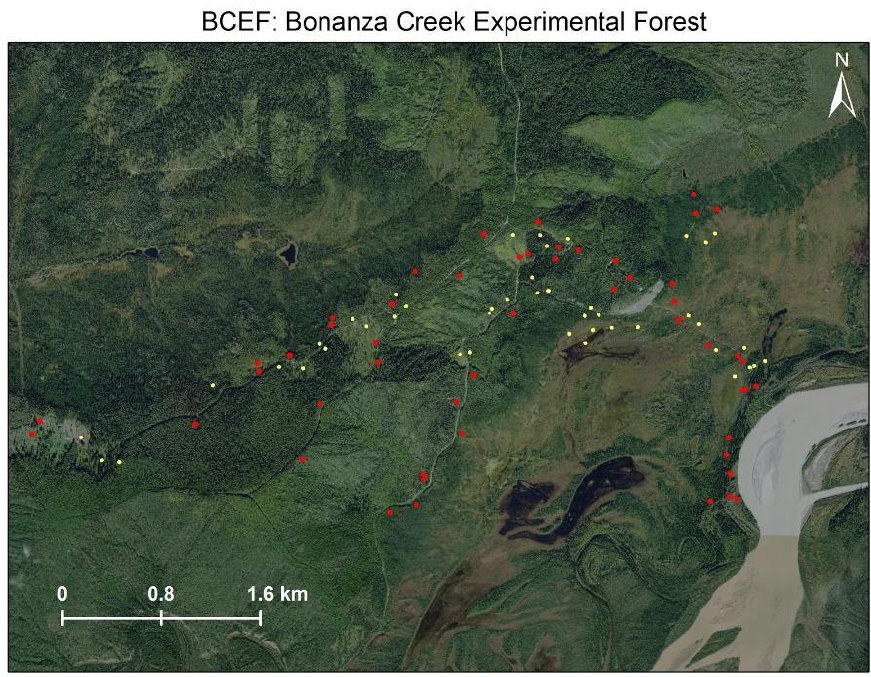
Figure 4. Map showing the 42 surveyed field plots (yellow) and 55 field locations (red) at BCEF.